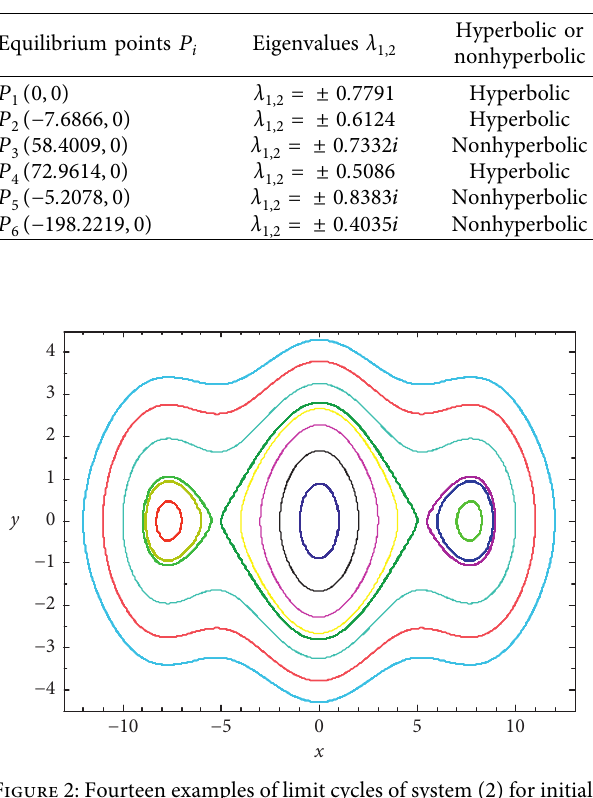
Figure 2: Fourteen examples of limit cycles of system (2) for initial conditions ( 1 , 0 ) , ( 2 , 0 ) , ( 3 , 0 ) , ( 4 , 0 ) , ( 5 , 0 ) , ( ± 5 . 5 , 0 ) , ( ± 6 , 0 ) , ( ± 7 , 0 ) , ( 10 , 0 ) , ( 11 , 0 ) , and ( 12 , 0 )